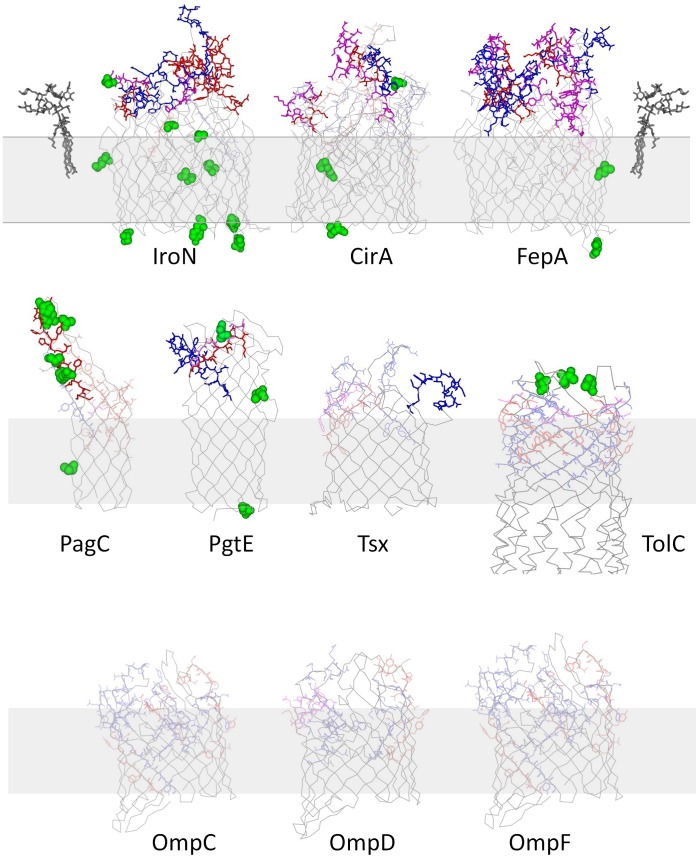
Structural models and exposed immune epitopes of various Salmonella outer membrane proteins.The outer membrane is shown as a grey area, predicted CD4 T cell epitopes in exposed loops are shown in red, potential antibody binding sites are shown in blue, and overlapping T and B cell epitopes are shown in magenta. Partially exposed epitopes are shown in pale colors. Amino acid residues that differ between Salmonella enterica serovars Typhimurium and Typhi are shown in green. For TolC only the outer membrane-associated part is shown. LPS structures as observed in FhuA-LPS crystals [93] are also shown.